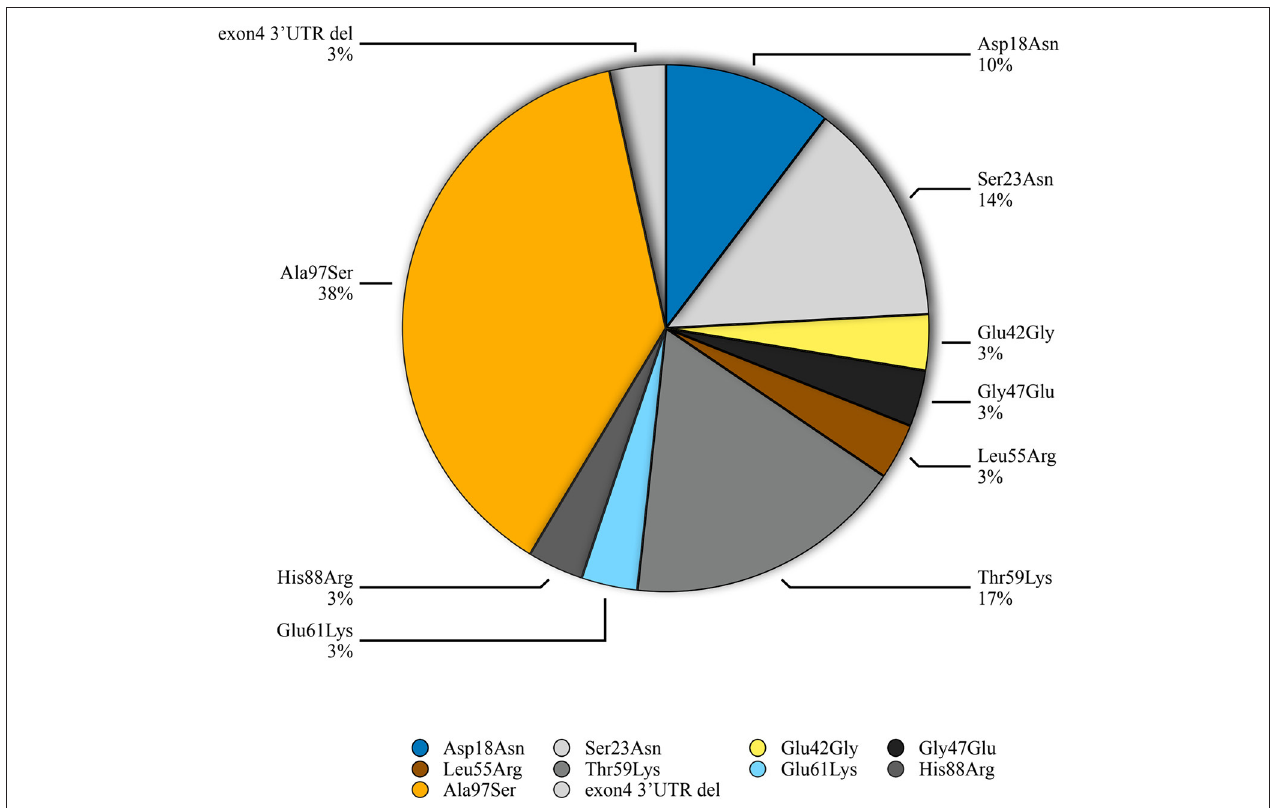
FIGURE 1 | Distribution of TTR mutations in a cohort of ATTR-CA patients from South China.